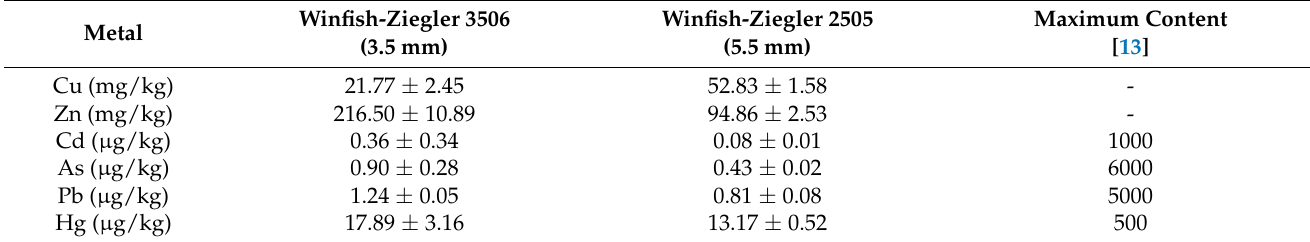
Table 1. Metal concentration of fish feedstuffs and the maximum content